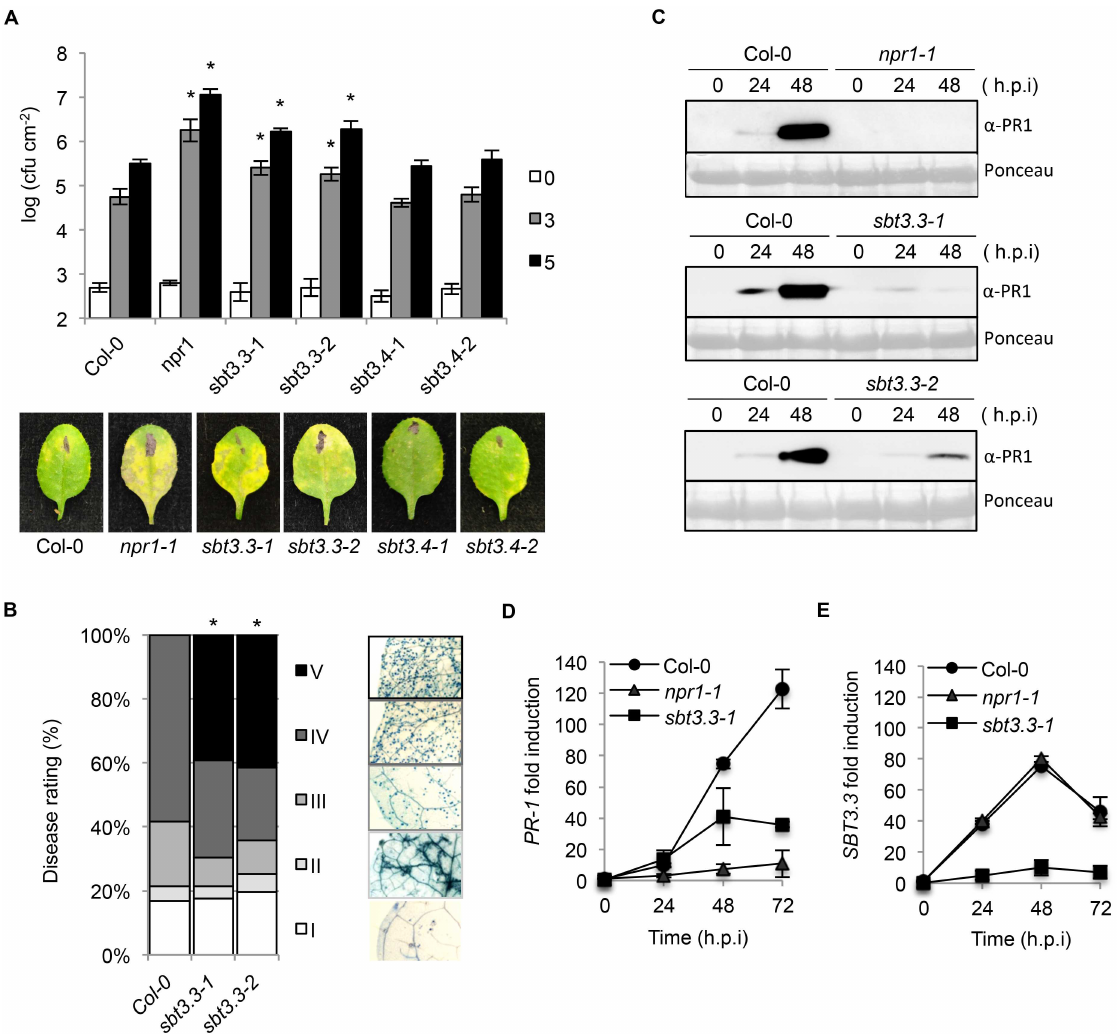
Fig 2. SBT3.3 loss of function increases disease susceptibility to P. syringae DC3000and H. arabidopsidis. (A) Five- week-oldplants were inoculatedwith PsDC3000. Zero (white bars), three (grey bars) and five (black bars) days after inoculation, the bacterial growth was measured.Error bars represent standard deviation(n = 12). Asterisks indicate statistical differences to Col-0 (P < 0.05) using Student’s t test. Below are representatives of inoculated leaves of the indicatedgenotypes. (B) Quantification of H. arabidopsidis conidia development on Col-0, and sbt3.3–1 and sbt3.3–2 mutants. Asterisks indicate statistically different distributions of disease severity classes comparedwith Col-0 plants ( χ 2 test; α = 0.05). (C) Western blots with anti-PR1 antibodies reveals inhibitionof PR1 induced accumulation in nrp1, sbt3.3–1 and sbt3.3–2 mutant plants, compared to Col-0, followinginoculation with PsDC3000. The experiments were repeated three times with similar results. (D–E)